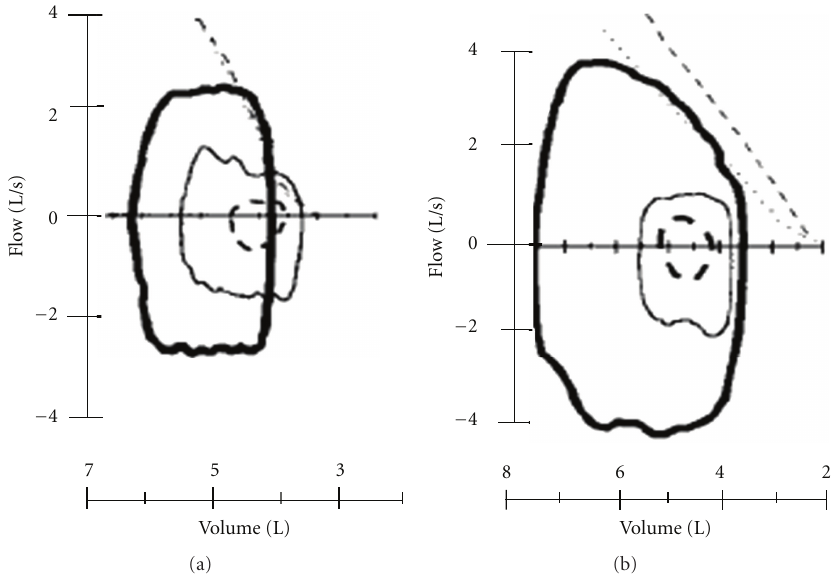
Figure 3: Tidal flow-volume loops at rest (dashed lines) at 40% of maximal ventilation (thin solid lines), and at maximum exercise (thick solid lines) in typical heart failure (a) and normal (b) subjects. The 2 oblique lines on flow-volume loops are partial forced expiratory flows recorded at rest (dotted line) and at maximum exercise (dashed line). From [12].